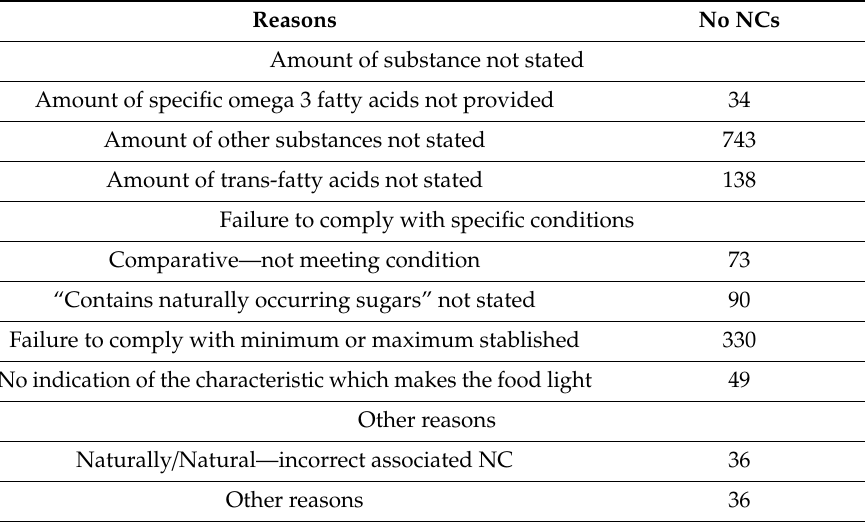
Table 3. Reasons for failing to comply with the regulation (only authorised NCs).